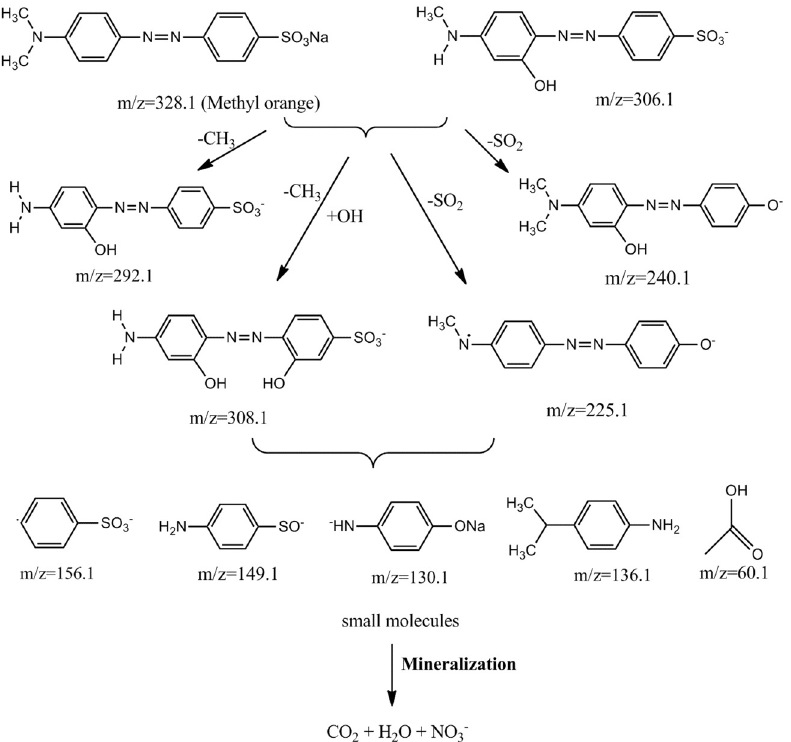
Figure 7: Proposed degradation pathway of MO under visible - light illumination using Cu/TiO 2 /LDH - 30 catalyst. Reproduced with permission from ref. [ 107 ] ; copyright ( 2018 ) ,